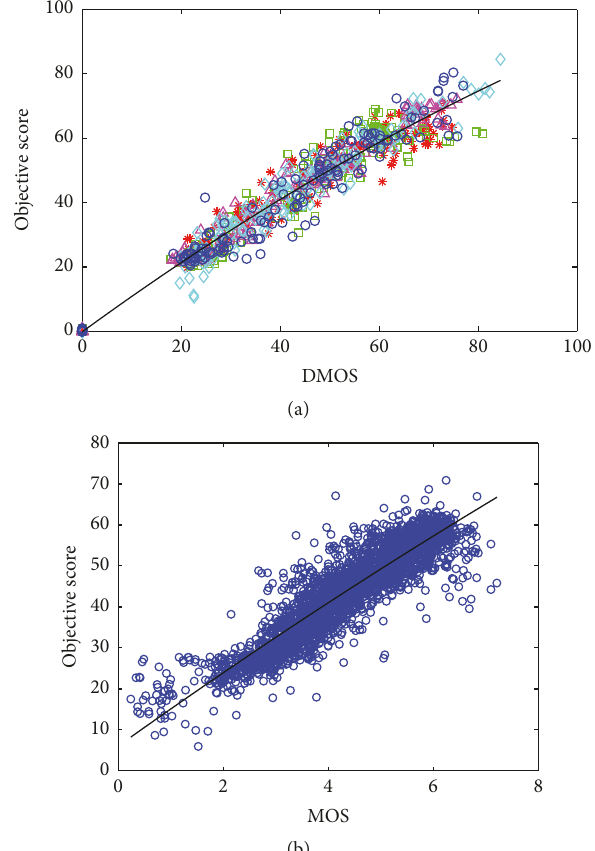
Figure 9: Scatter maps of objective and subjective scores on LIVE (a) and TID2013 (b) databases.